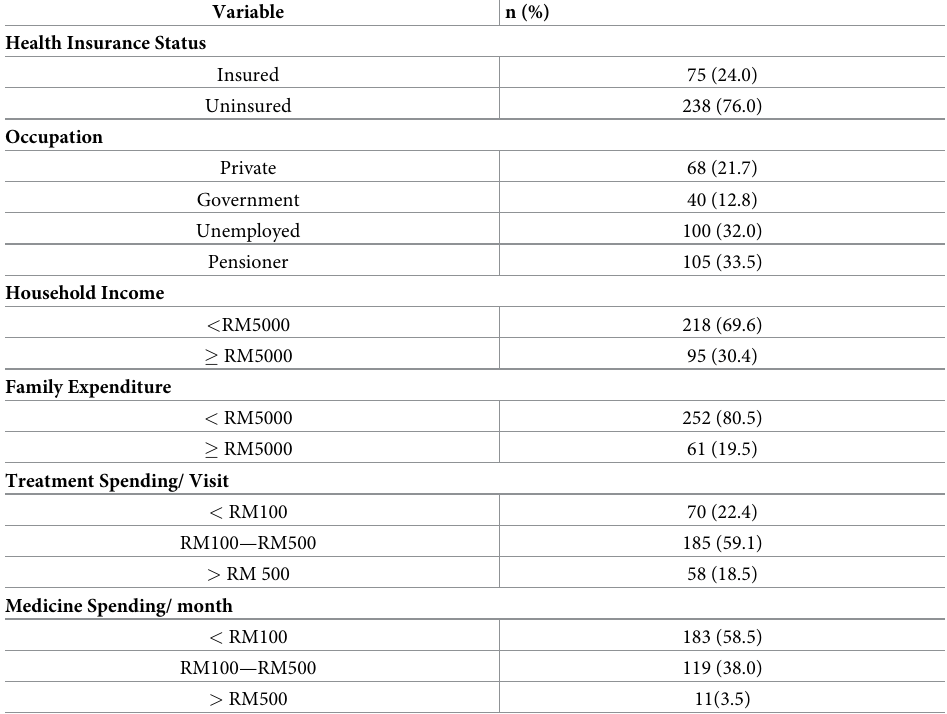
Table 2. Distribution of respondents by socioeconomic